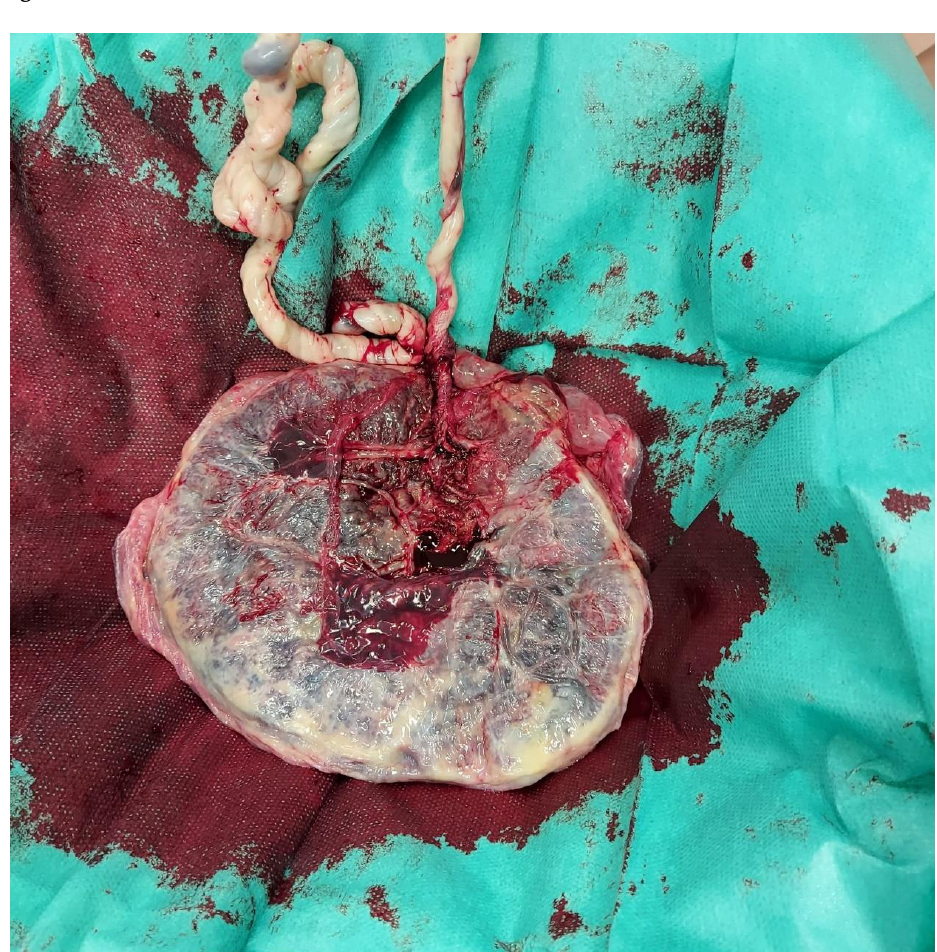
Figure 2. The placenta and marginal umbilical cord implant.